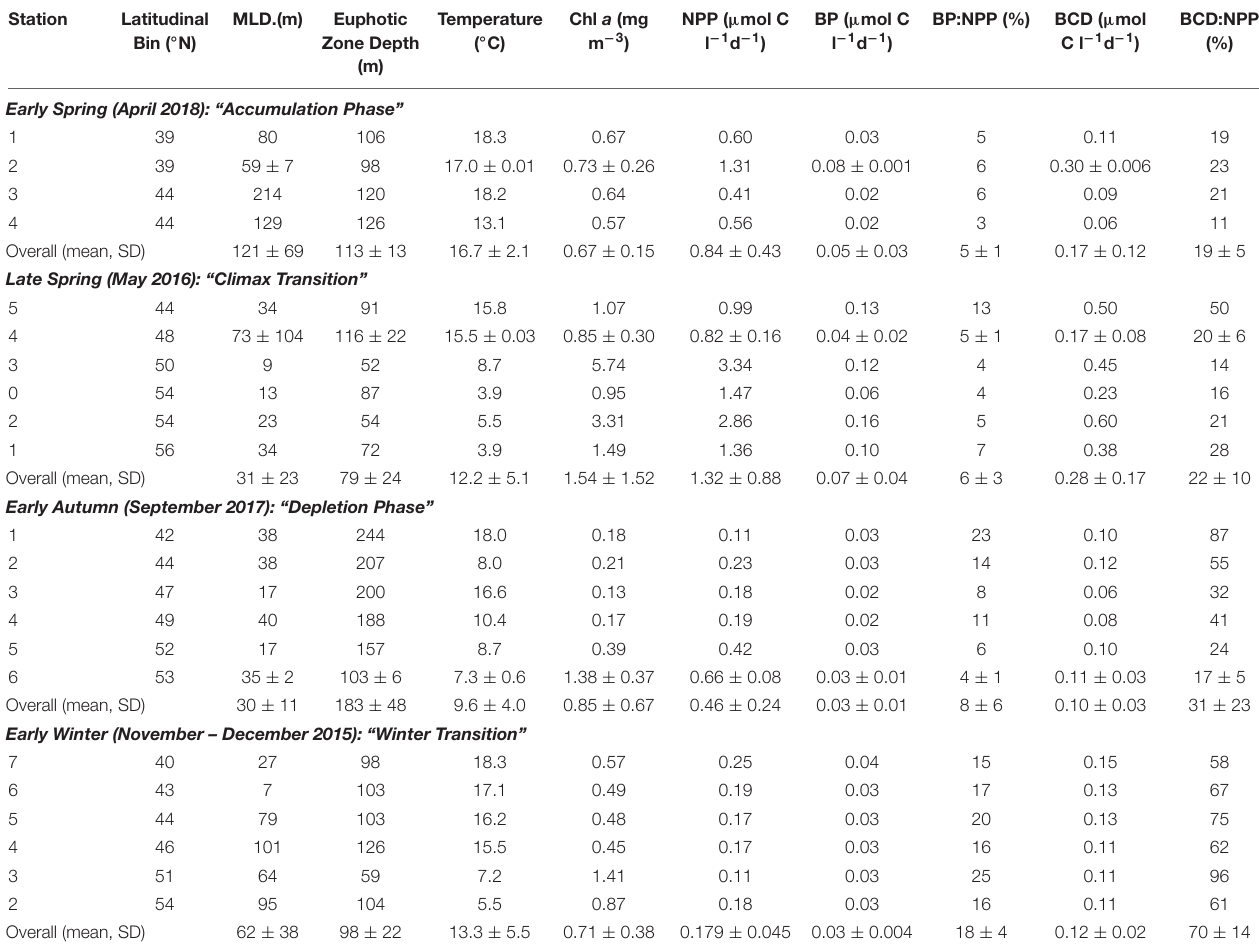
TABLE 2 | NPP, BP, and